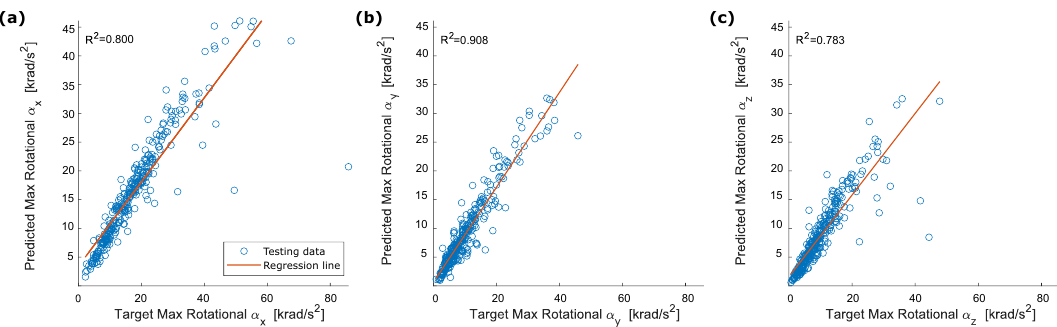
Figure 9. Correlation between target and predicted peak rotational acceleration: (a) α x ; (b) α y ; (c) α z